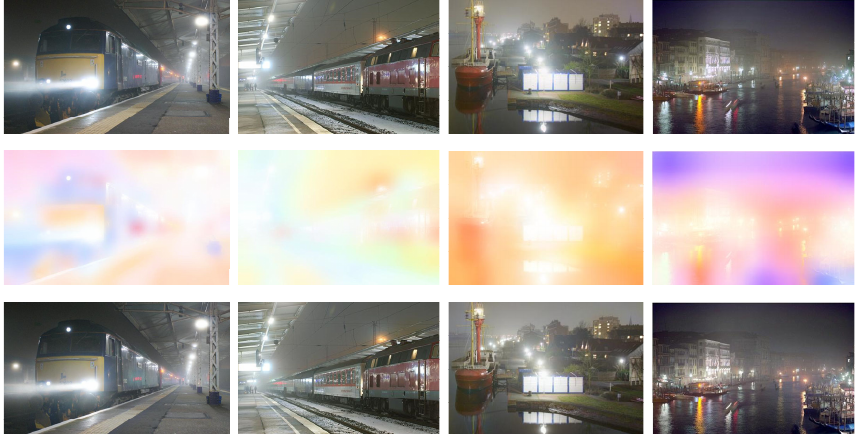
Figure 3. Color maps and the results of color correction. The first row shows the hazy images. The second row shows the color maps obtained by (10). The last row shows the hazy images after removing the color